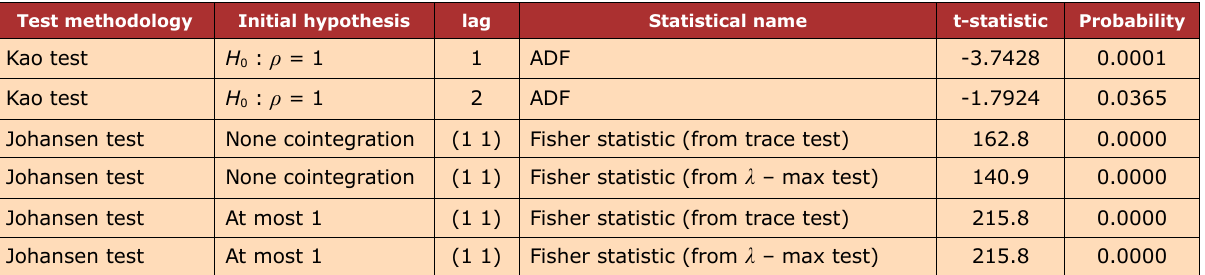
Table 4. Cointegration estimation of panel data between environmental performance and financial performance